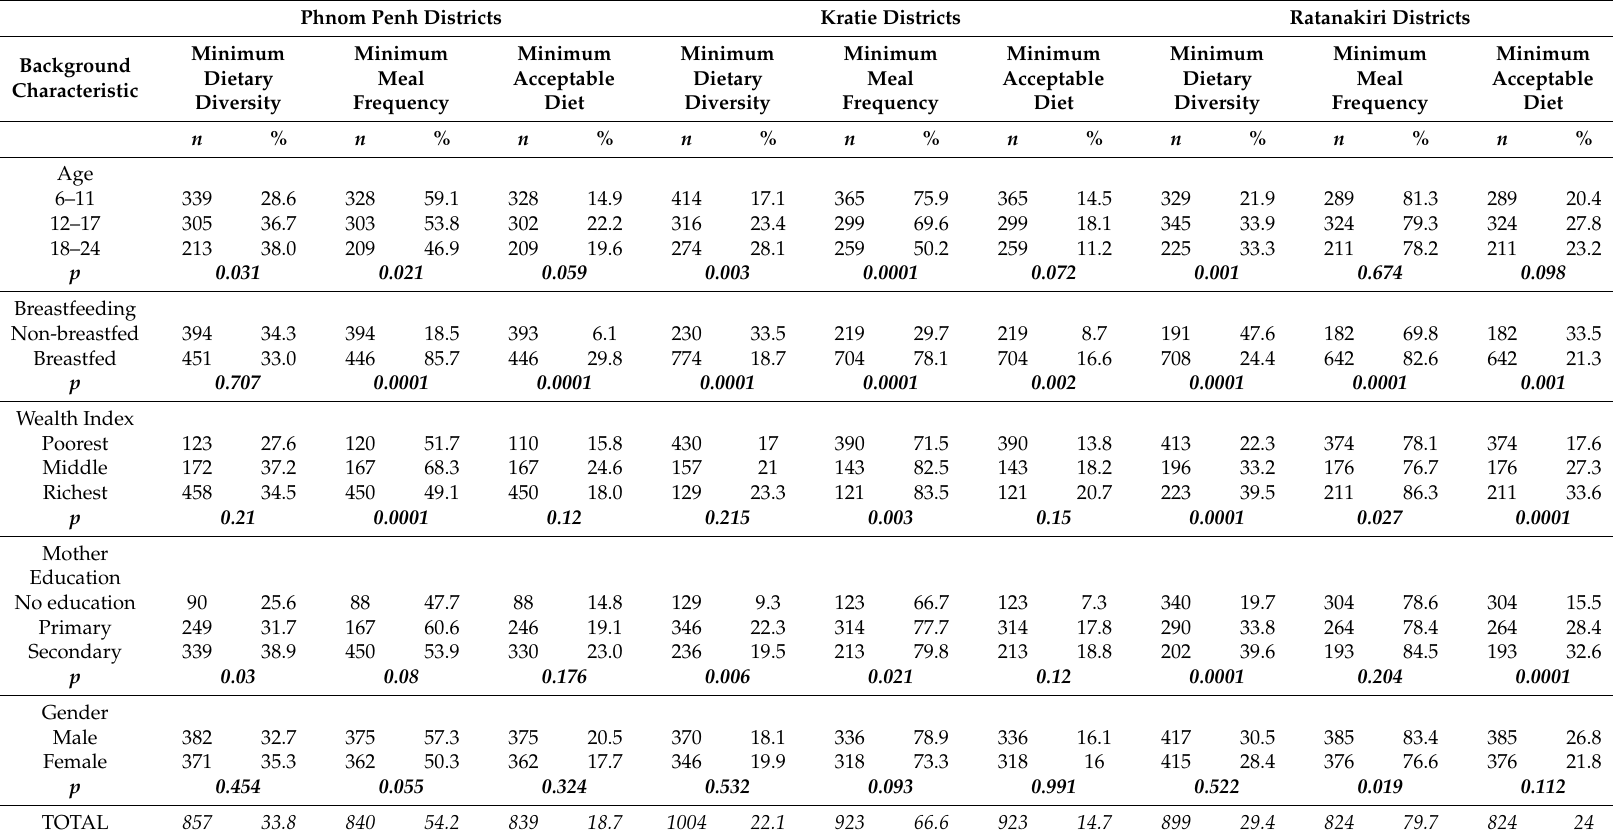
Table 2. Infant and young child feeding